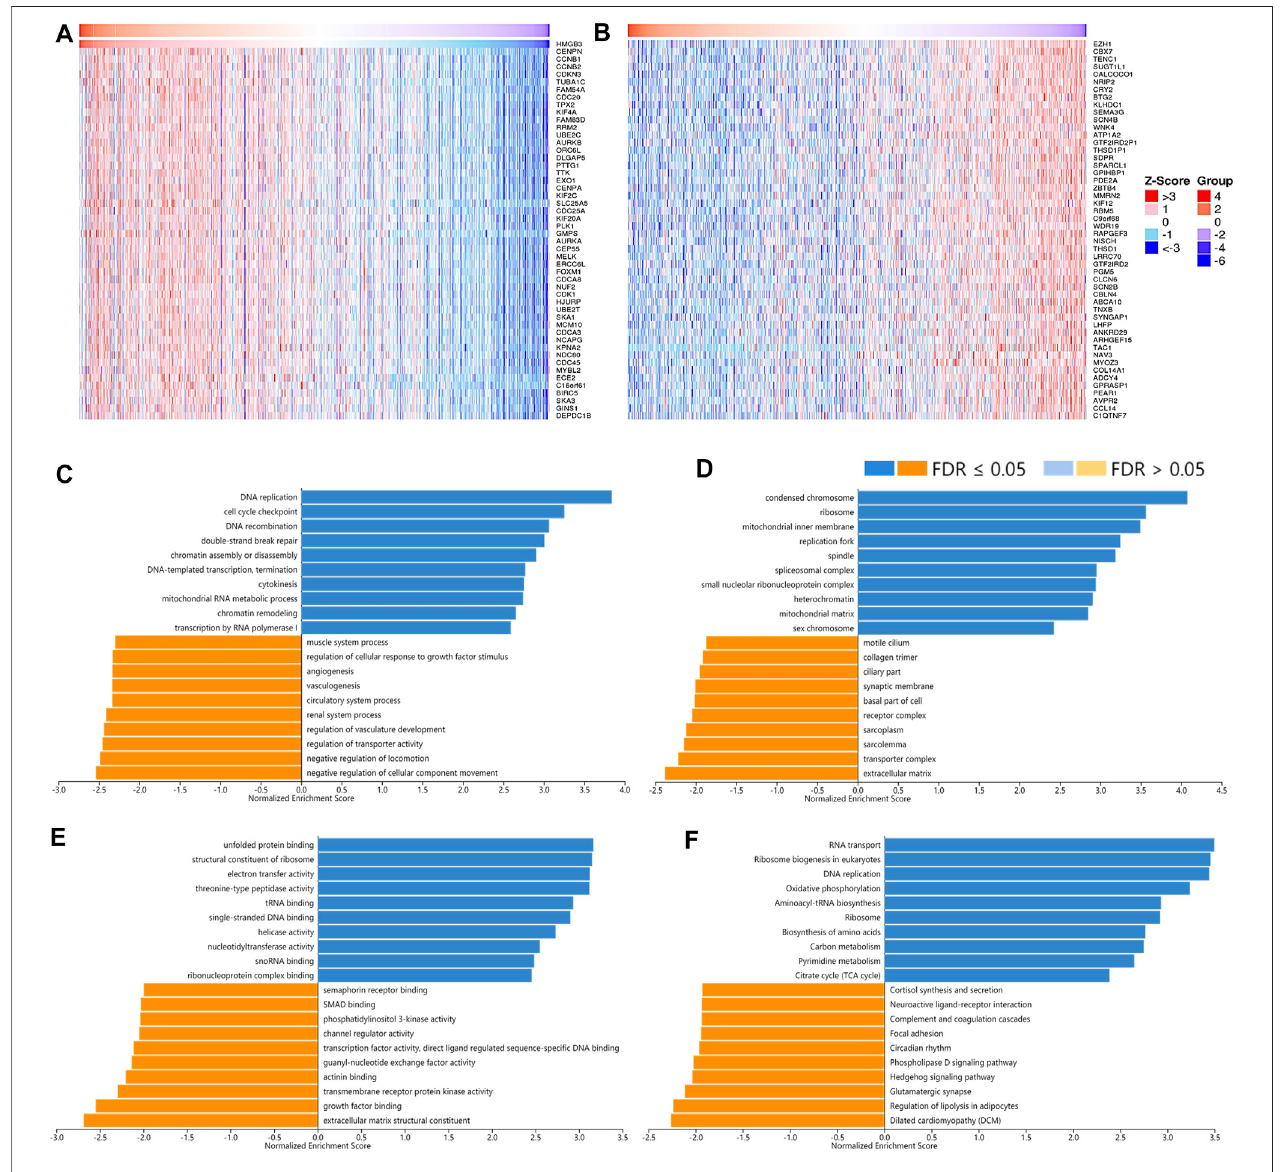
FIGURE 9 | The correlated genes of High Mobility Group Box 3 (HMGB3) in BRAC and GSEA results. The top 50 genes signi fi cantly (A) positively and (B) negatively correlatedwithHMGB3inBRAC(LinkedOmics). Thetop 20signi fi cantlyenriched (C) GO-BP, (D) GO-CC, (E) GO-MF,and (F) KEGGpathway terms ofHMGB3correlated genes based on GSEA. A bar represents a normalized enrichment score for a term, which in orange or blue represents negatively or positively enriched, respectively.